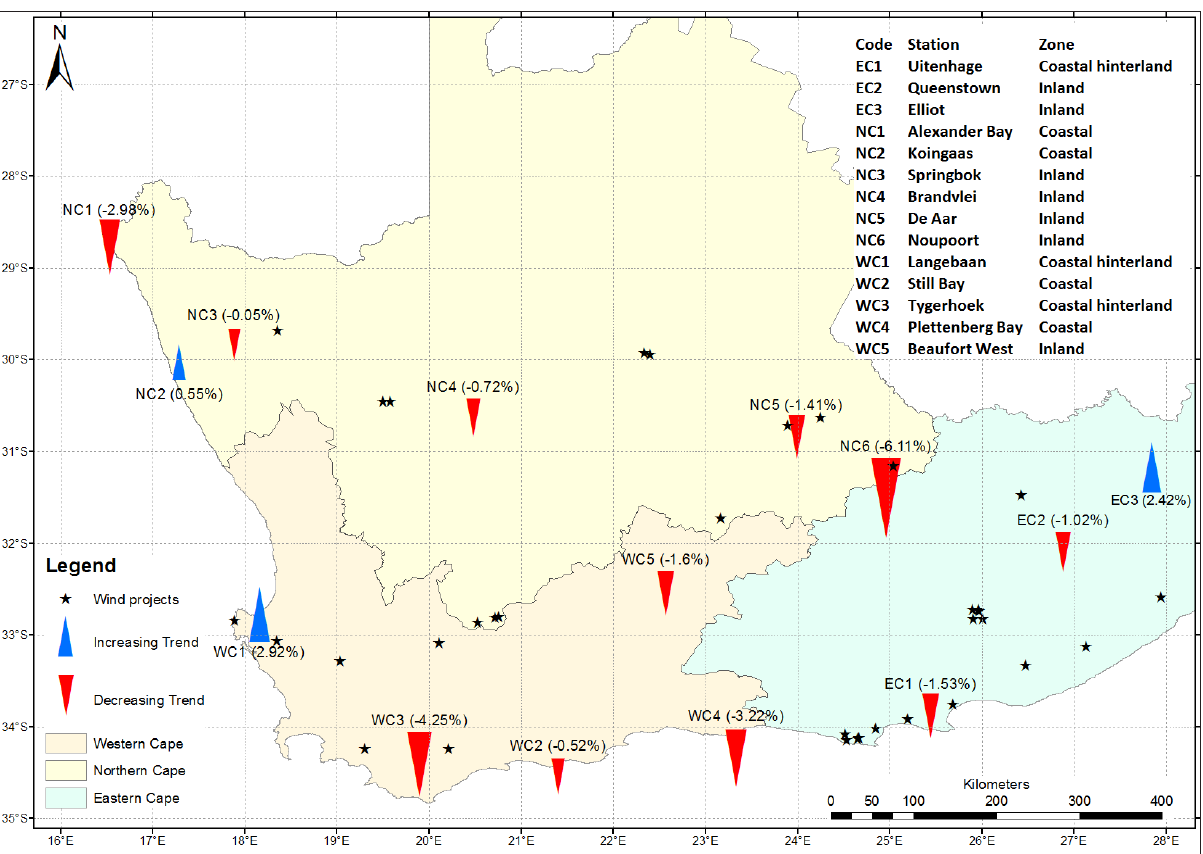
Figure 1: Mean short-term wind speed trends (1995–2014) mapped for the Northern, Western and Eastern Cape regions of South